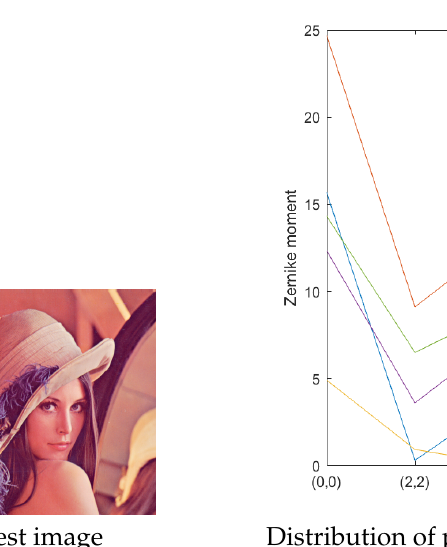
Figure 12. Pseudo-Zernike moments expression